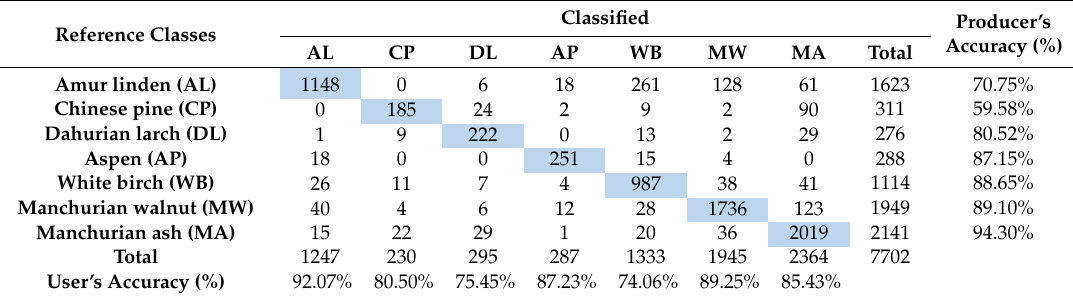
Table 3. Confusion matrix of the test set by the Conv1D-based classifier.